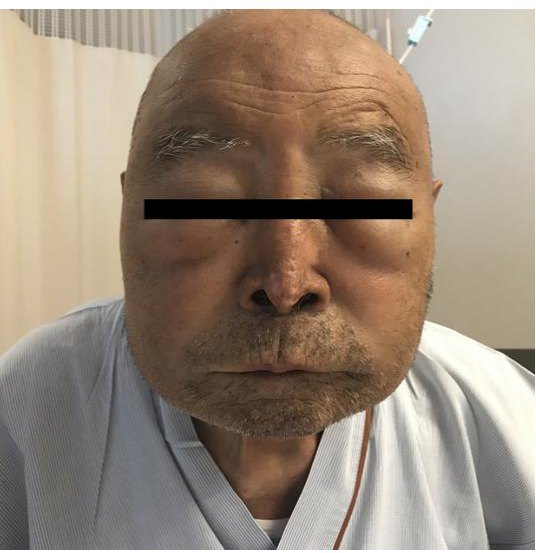
Figure 1. Facial pitting edema mainly on the eyelids at time of hospital admission.